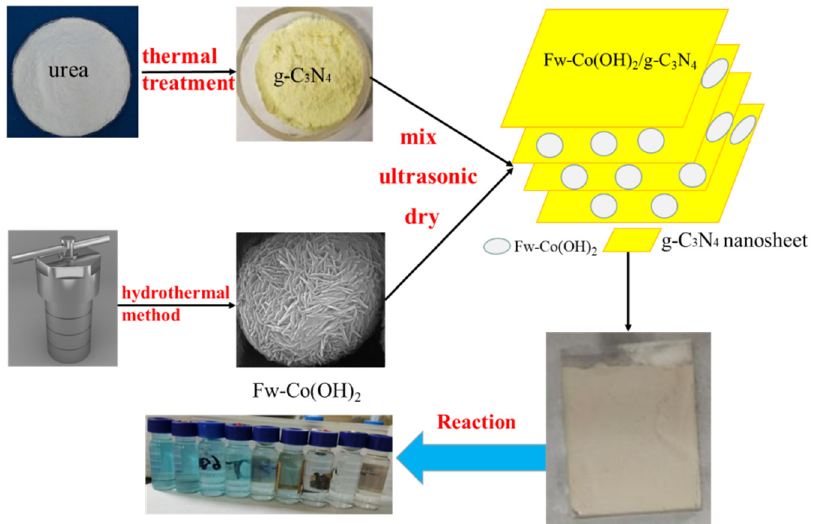
Figure 1. Schematic diagram of the synthesis process.